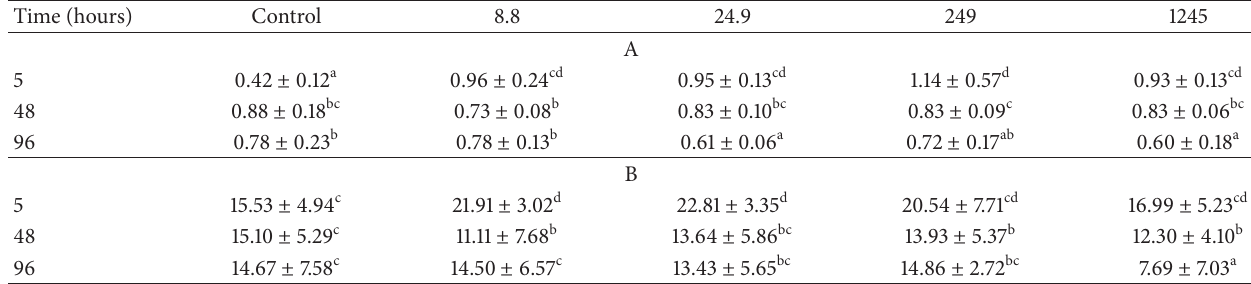
Table 2: Mean ( ± SD) hemocyanin (A: mmolL − 1 ) and protein (B) concentrations (mg mL − 1 ) of L. vannamei exposed to four concentrations ( 𝜇 gL − 1 ) of cadmium.